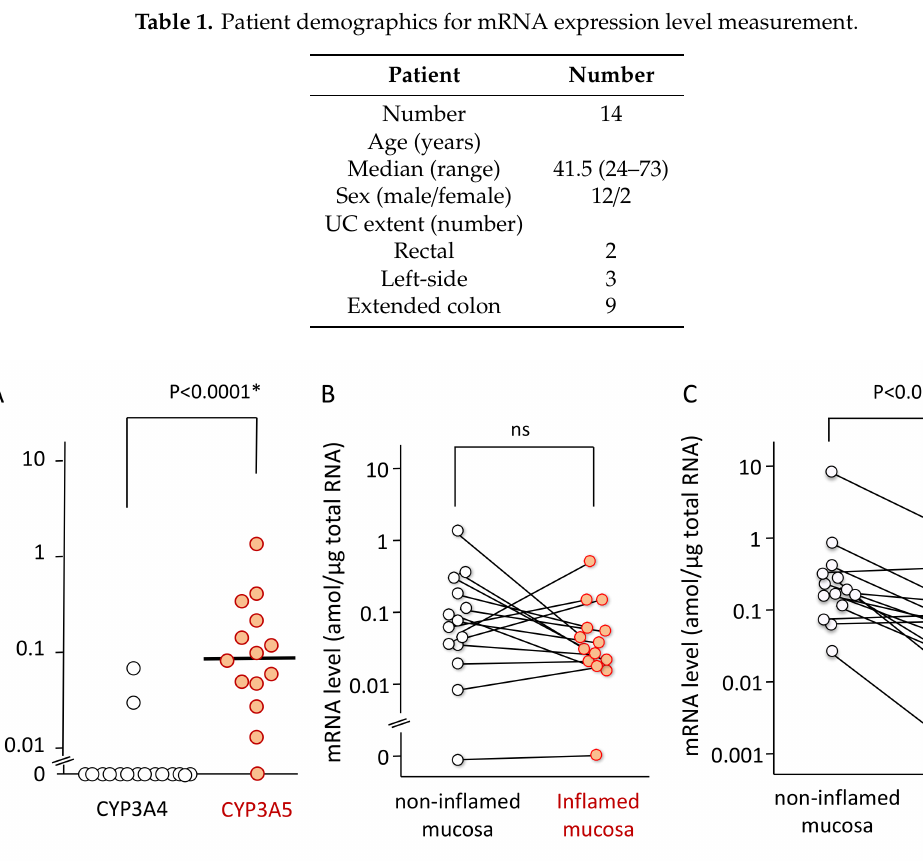
Figure 1. The mRNA expression levels of CYP3A4 and CYP3A5 in colonic or rectal mucosa ( A